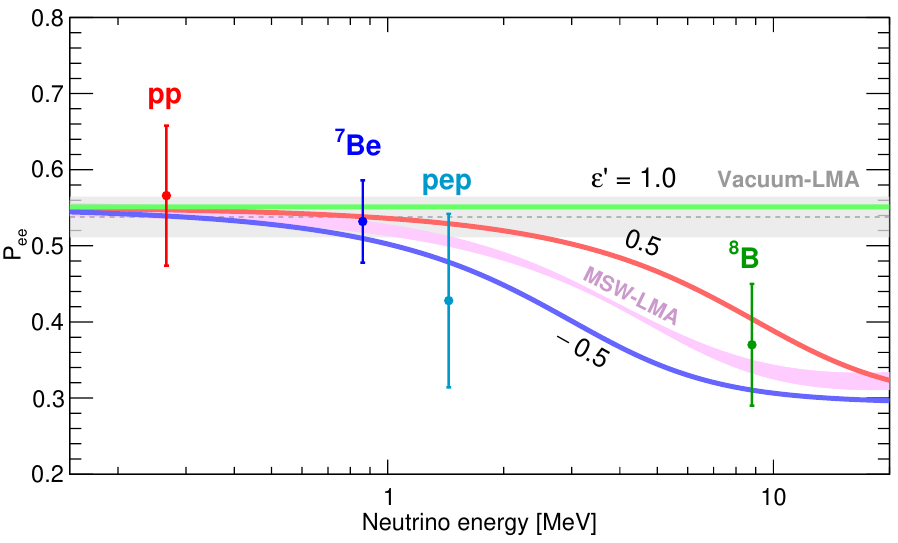
Figure 1 . Electron neutrino survival probability P ee ( E ) as a function of neutrino energy for LMA- MSW solution with uncertainties of oscillation parameters taken into account (pink band), and LMA-MSW + NSI solutions for " 0 = (cid:0) 0 : 5 ; 0 : 5 ; 1 : 0 and average values of oscillation parameters. Vacuum oscillations scenario with LMA parameters is also shown (grey band). To illustrate the capability of the detector to sense NSI’s at propagation, experimental points for P ee ( E ) shown for Borexino under the HZ-SSM assumption are also provided (ref. [18]). 8 B and pp data points are set at the mean energy of neutrinos that produce scattered electrons above the detection